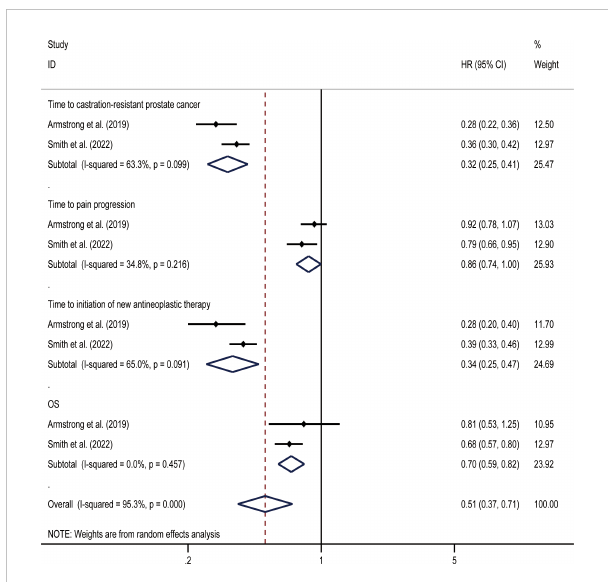
FIGURE 3 Results of a direct meta-analysis on the mHSPC